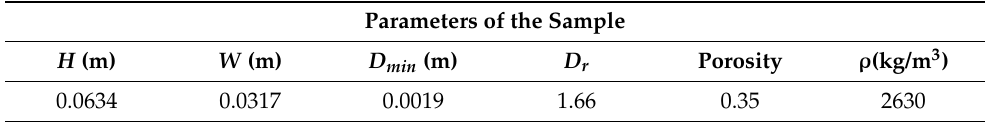
Table 3. Parameters of the 3D sample. H, W, D min , D r , ρ are the sample height, sample diameter, minimum disc diameter, maximum to minimum diameter ratio, and density of the particles.